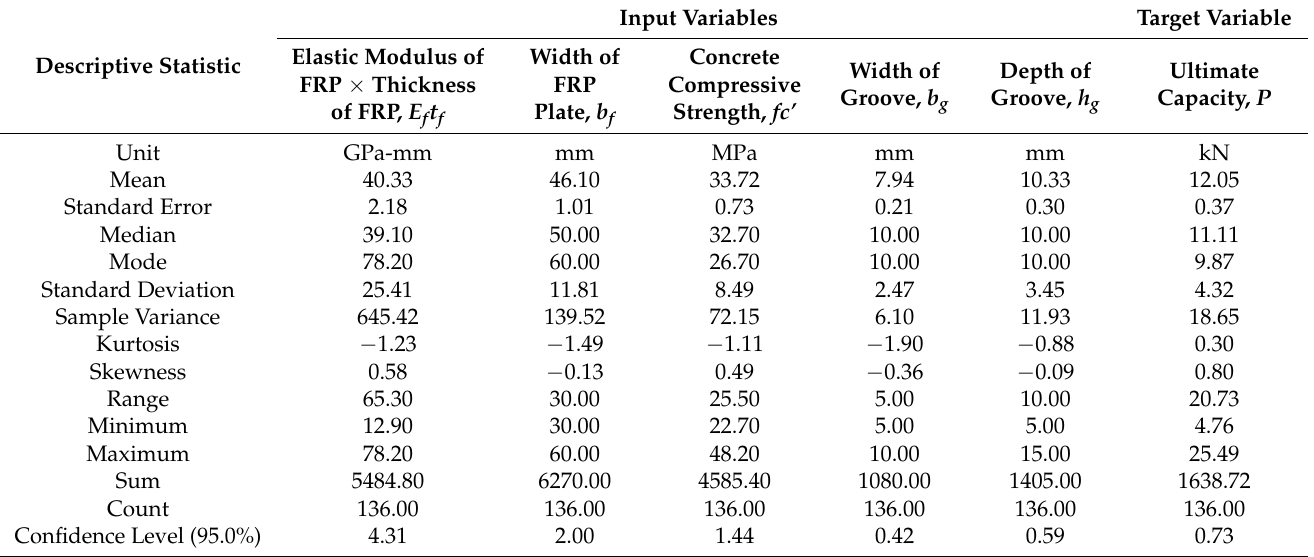
Table 1. Descriptive statistics of the variables used in the development of the GEP